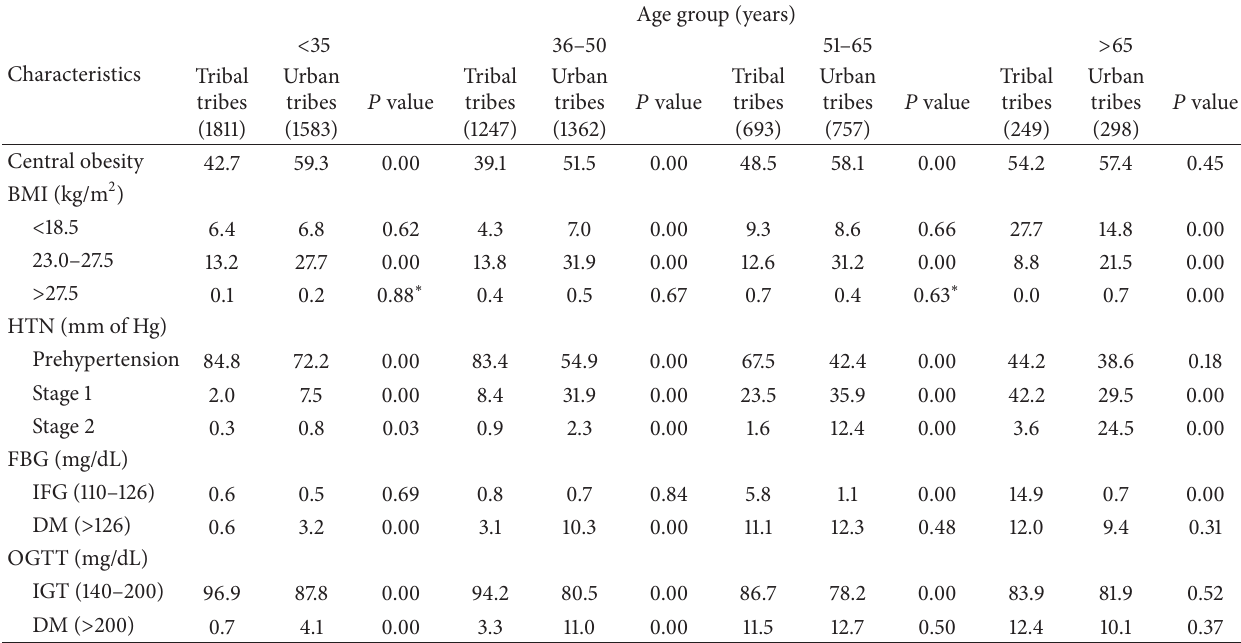
Table 6: Age group distribution of mean levels of anthropometry, blood glucose, and alcohol consumption among tribes of urban and tribal areas, Himachal Pradesh,